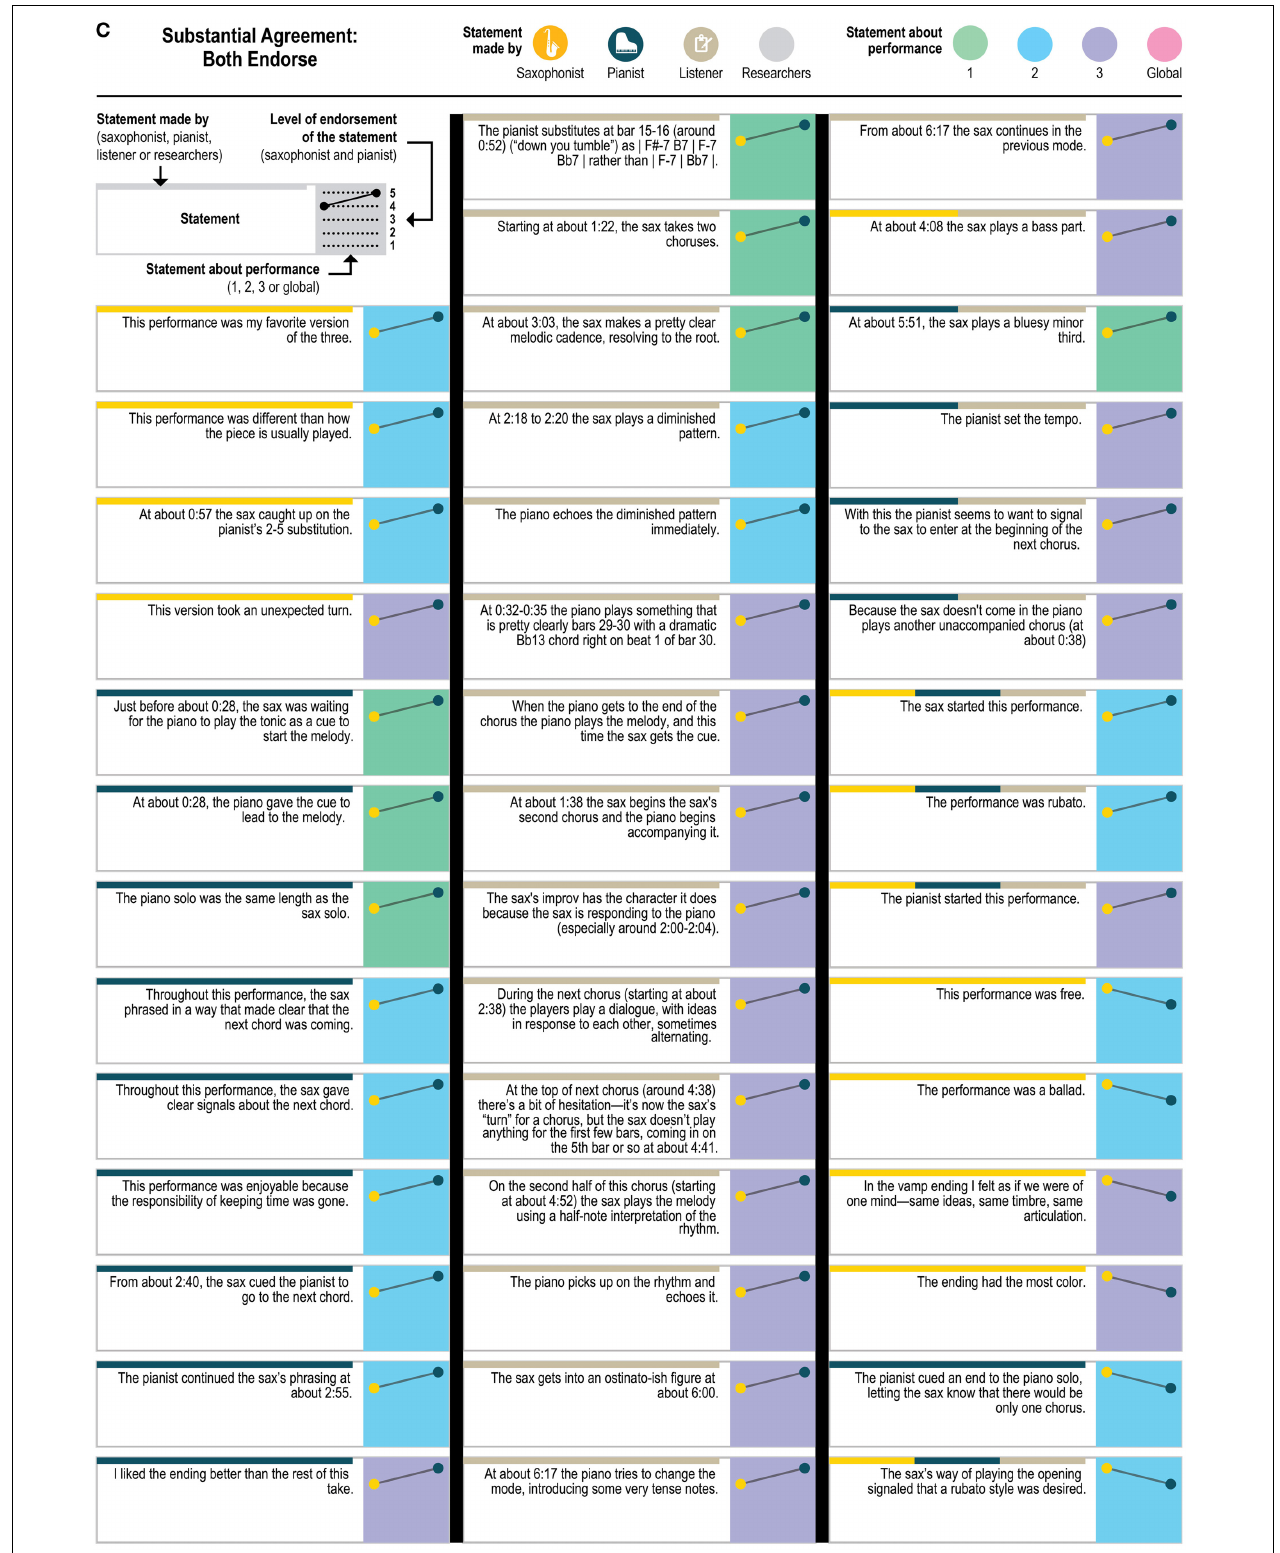
FIGURE 5C | Statements with substantial agreement (ratings different by only 1 point) that both players endorsed.